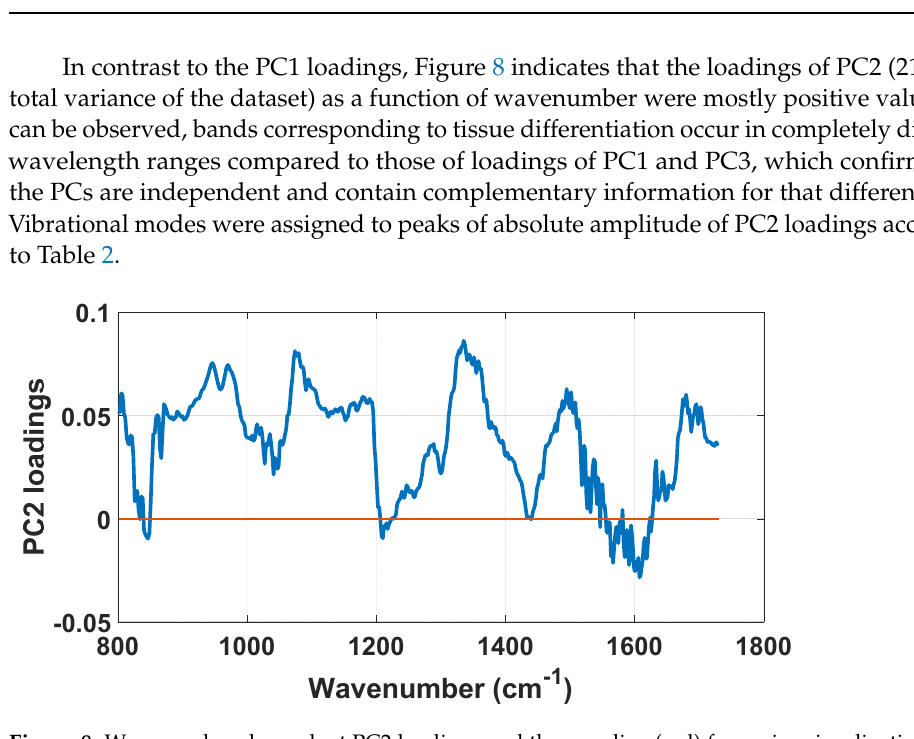
Figure 8. Wavenumber-dependent PC2 loadings and the zero line (red) for easier visualization of the absolute amplitude of loading values. Table 2. Vibrational modes assigned to peaks of absolute values of PC2 loadings